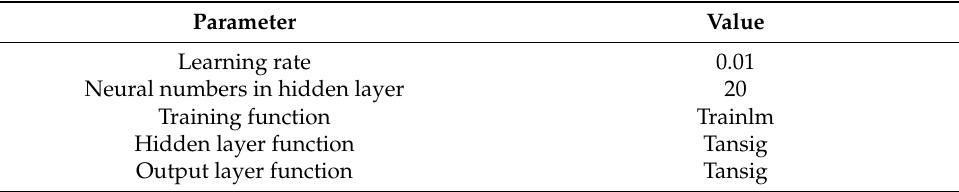
Table 1. Training parameter settings.